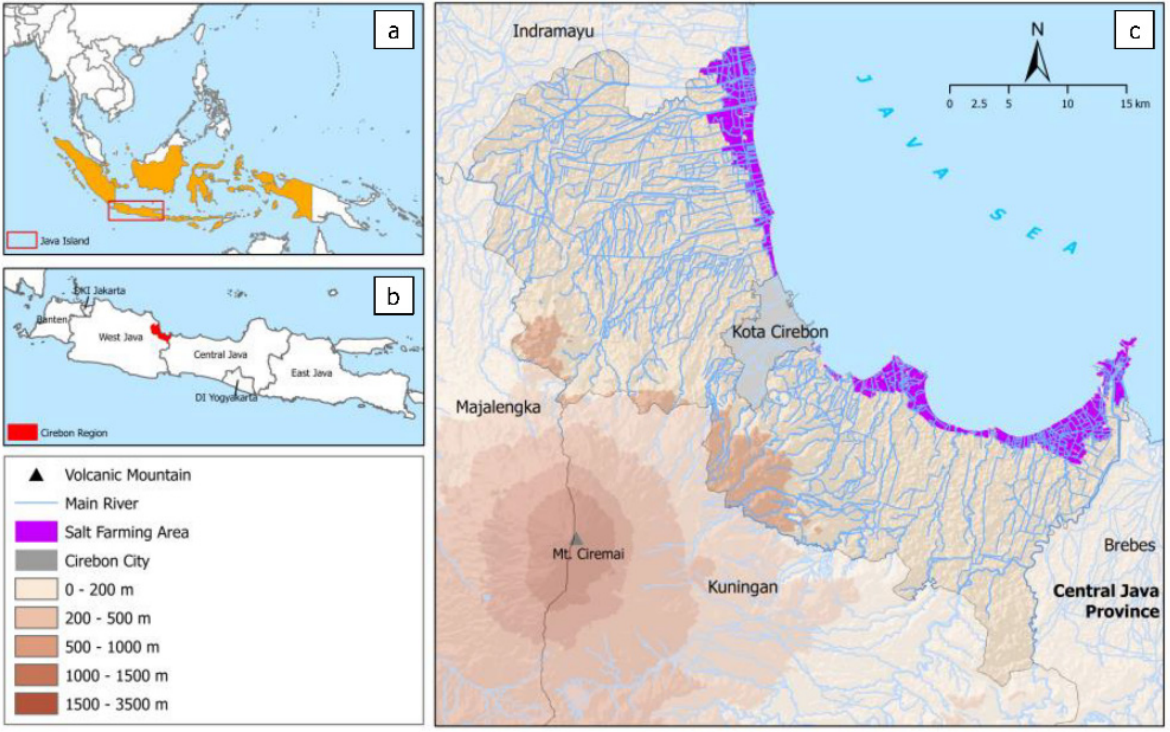
Figure 1. Map showing the case study area and its topographical situation. ( a , b ) indicate the case study area in the Southeast Asia region and on Java island, respectively. The red-line box in ( a ) shows Java as a part of the Indonesian archipelago (orange). In ( b ), the red marking shows the location of the Cirebon region in the West Java province. ( c ) portrays the topographical condition of the study area, river systems, and salt farming parcels (magenta) located along the